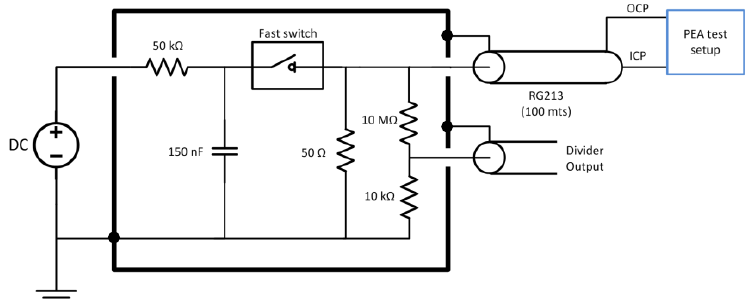
Figure 3. Voltage pulse generator equivalent circuit. OCP stands for the outer conductor terminal of the pulsed voltage cable at the PEA setup side, and ICP stands for the inner conductor terminal of the pulsed voltage cable at the PEA setup side.